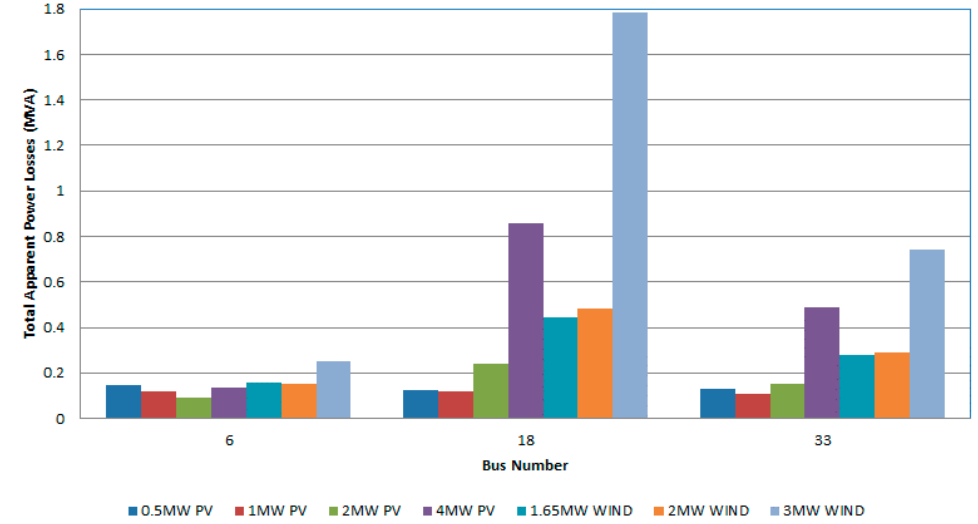
Figure 8. Total network apparent power losses when different DG unit sizes have been connected at bus 6, 18 and 33 respectively.